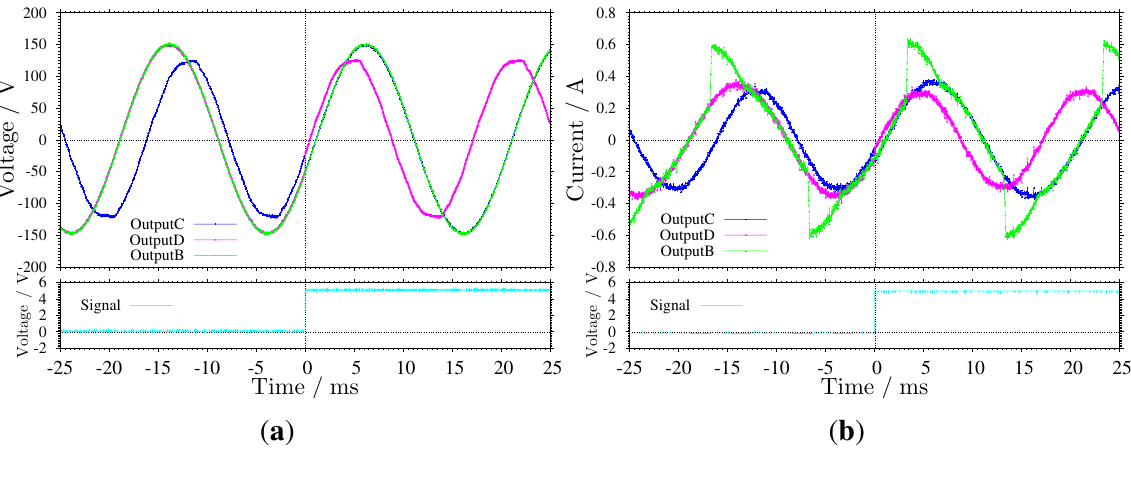
Figure 11. Output waveforms in a series connection when the downstream power router #2 exchanges lines: ( a ) output voltage waveforms; and ( b ) output current